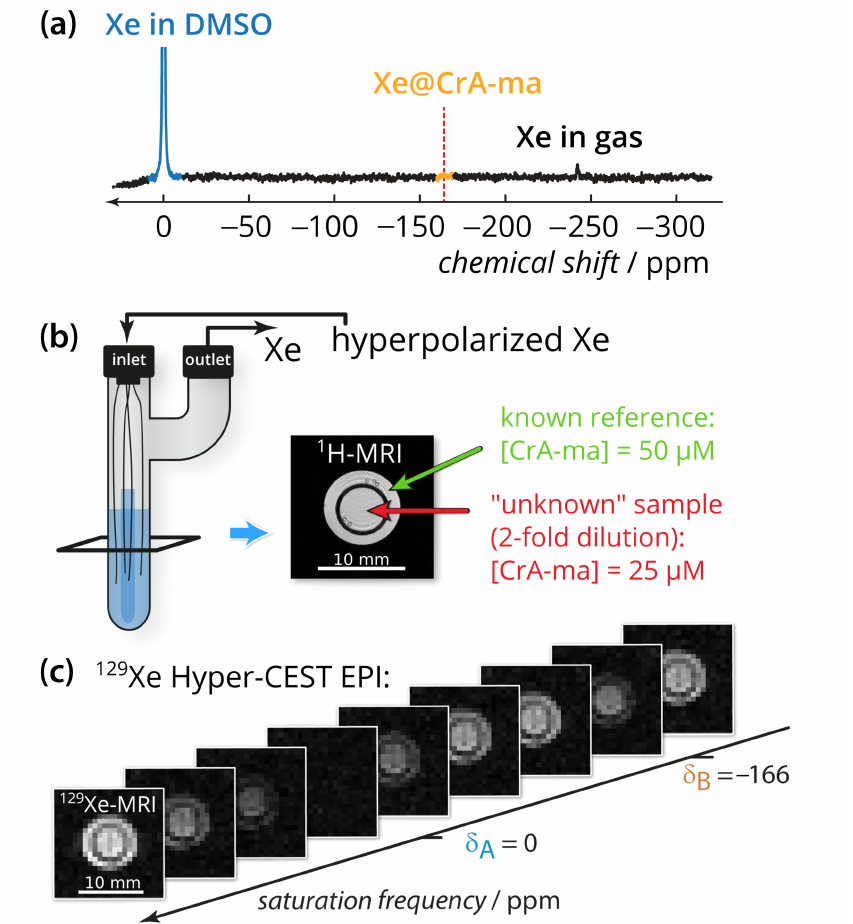
Figure 1. Experimental setup. ( a ) Direct 129 Xe NMR spectrum with 100-fold zoom of 16 scans of the sample described in subfigure ( b ). The red dashed line indicates the chemical shift of the Xe@CrA- ma in DMSO resonance. ( b ) Two-compartment phantom including glass capillaries and sample (blue). A gas mixture of freshly hyperpolarized Xe was bubbled into the sample via the inlet and is vented via the outlet. The outer compartment (green arrow in the axial 1 H-MRI) contained the known reference concentration with [CrA-ma] = 50 µ M, whereas the inner compartment (red arrow) carried the “unknown” concentration (in fact, the 2-fold dilution; 25 µ M). ( c ) 129 Xe Hyper-CEST-EPI axial images series with respect to the saturation frequency. Whereas complete saturation occurs at the saturation frequency of free Xe at δ A , only a fraction is saturated at the CrA-ma-bound Xe δ B . The pixel-wise qHyper-CEST analysis was done for saturation with B 1 , t sat = {3.3,5; 5.6,10; 2.2,15} µ T,